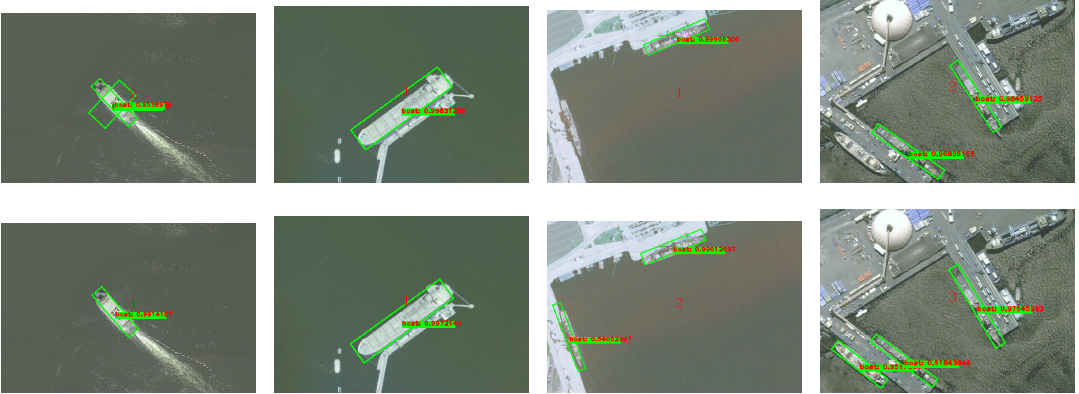
Figure 11. Visual effects of contextual RRoI